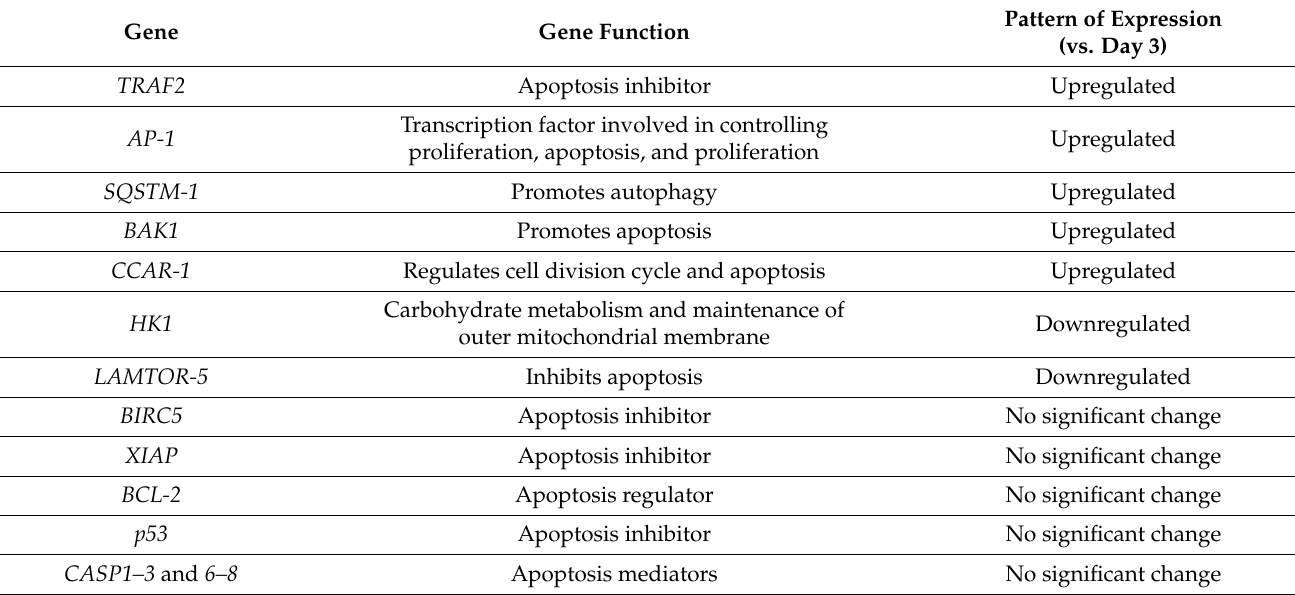
Table 2. Apoptosis-related genes in the RNC